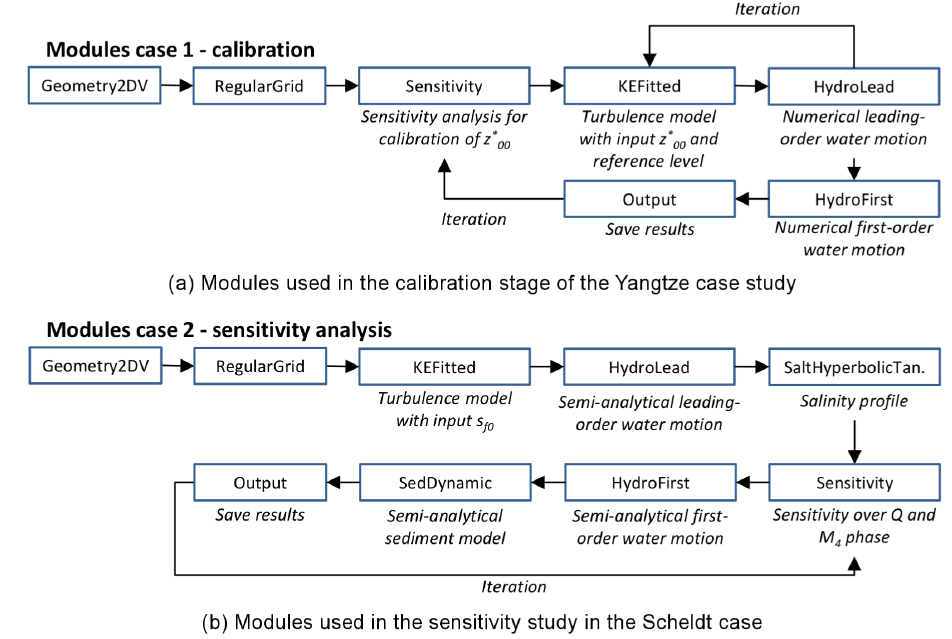
Figure 4. Modules used in two stages of the case studies, put into the correct order and including iteration loops over groups of modules.